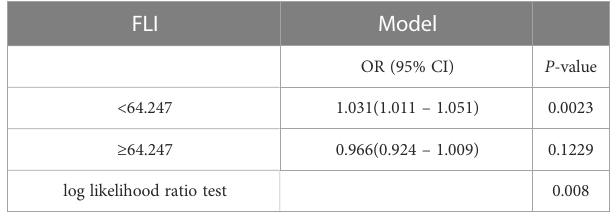
TABLE 3 Threshold effect analysis of the relationship of FLI with